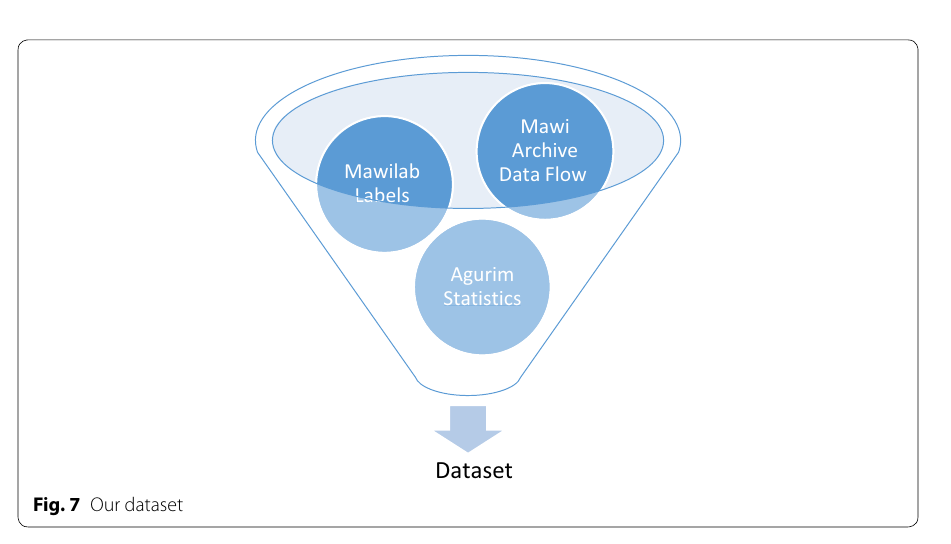
Fig. 7 Our dataset